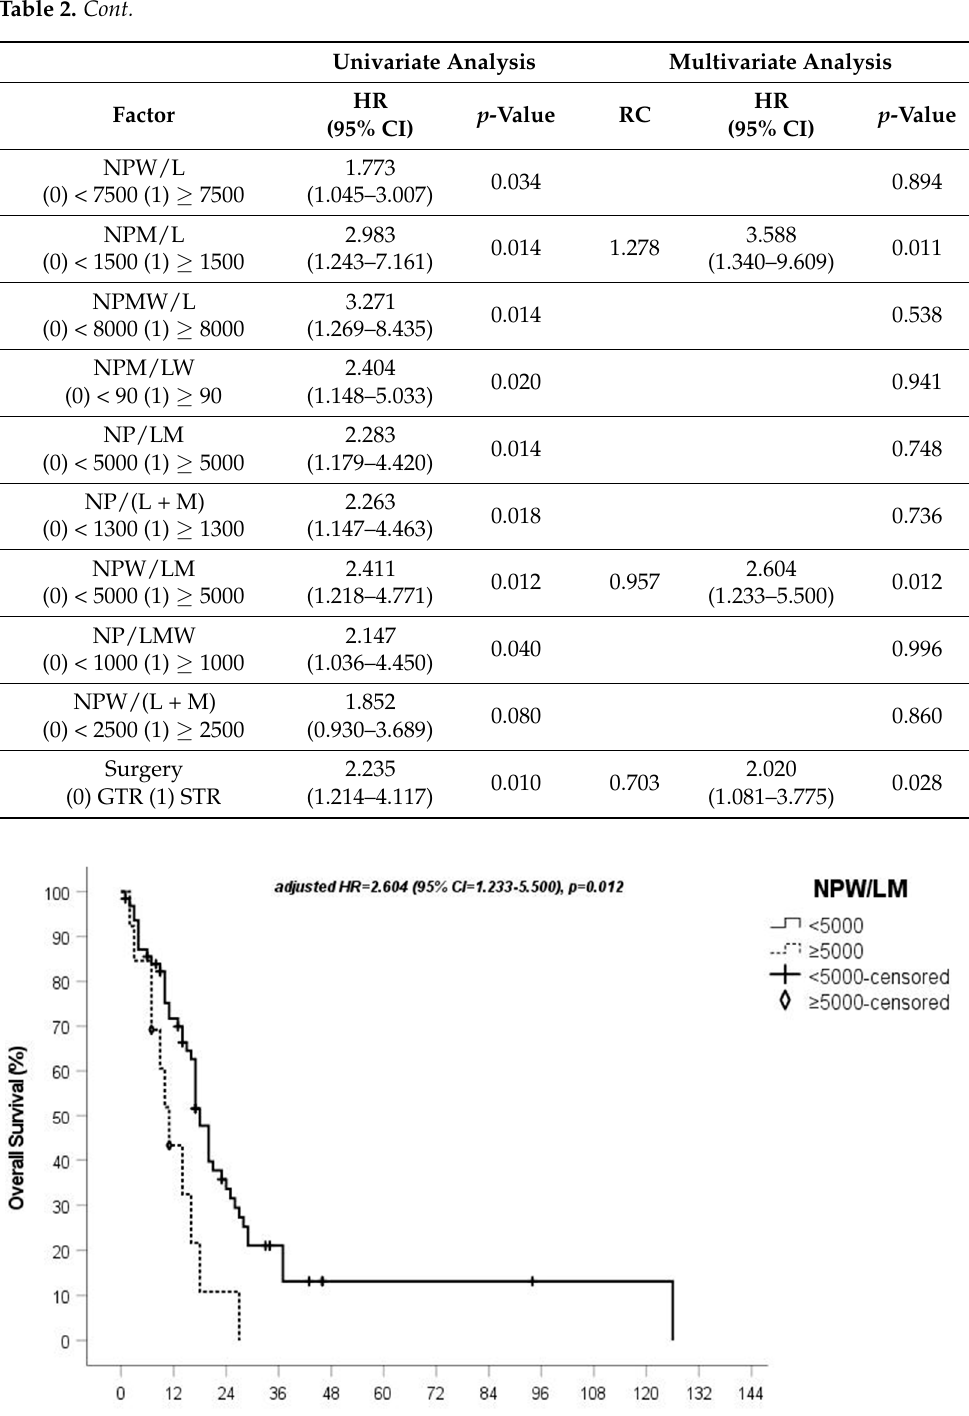
Figure 1. Survival outcomes, based on NPMW/LM value